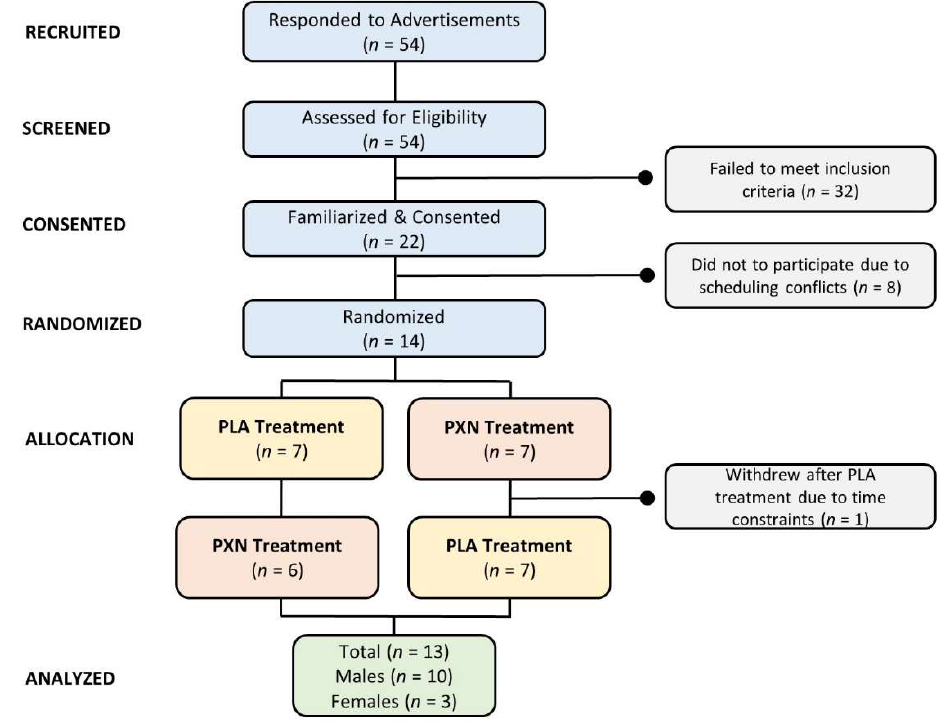
Figure 1. Consolidated Standards of Reporting Trials (CONSORT) diagram of the study.